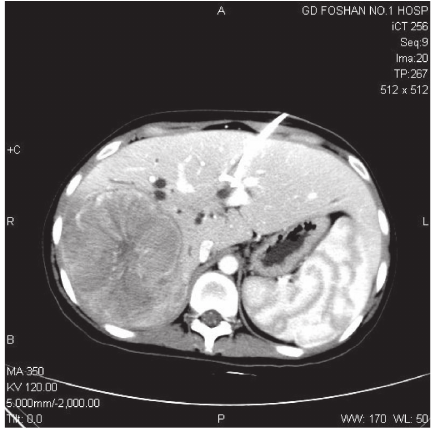
Figure 1: Computerized tomography (CT) angiography showed a HCC at the right posterior sector accompanied by adjacent small satellite foci.